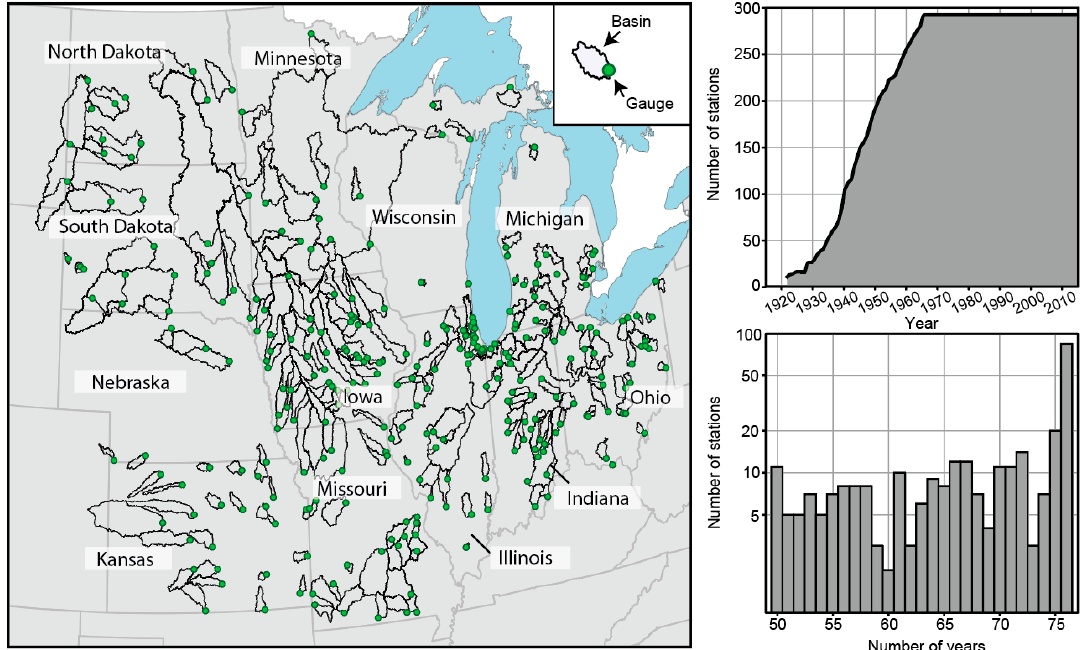
Figure 1. Location of the 290 study sites and their contributing drainage basins across the Midwest. Contributing drainage basins are outlined in black and may extend beyond the region that is shown in the figure. The top right panel shows the number of stations with complete data in every year (a continuous record of at least 50 years before 2015 is required). The bottom right panel shows the histogram of record length for the 290 stations.